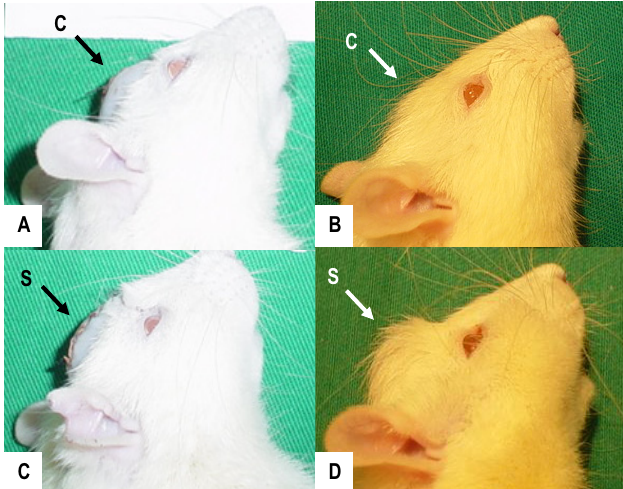
FIGURE 4 - Clinical evaluation of the boss in the area of the carbon or silicon implant